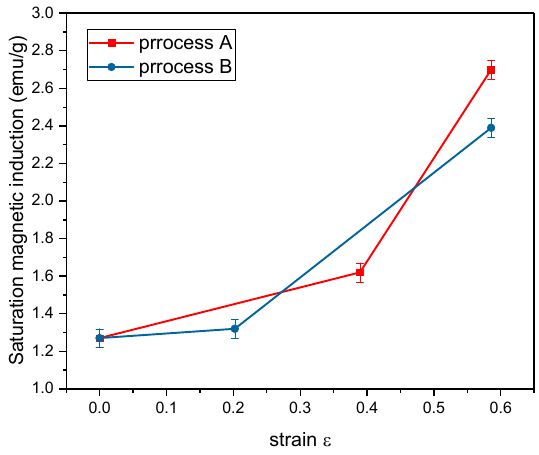
Figure 11. Deviation of saturation magnetic induction Bs with the change of strain.